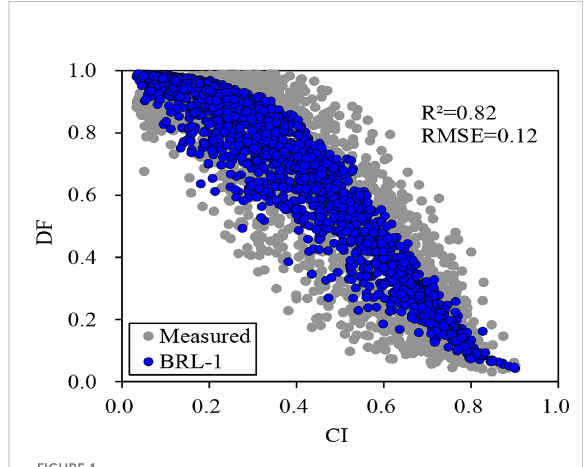
FIGURE 1 Scatter plot between clearness index (CI) and measured, simulated (BRL-1 Model) diffuse fraction